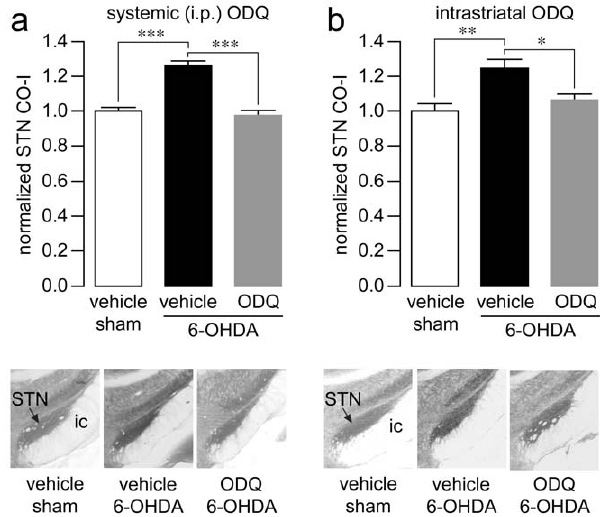
Figure 3. Role of the indirect striatopallidal pathway in mediating the ODQ-dependent reversal of STN hyperactivity. ( a ) Bar graph showing levels of CO-I staining in the STN of sham- operated and 6-OHDA lesioned rats following systemic administration of vehicle or ODQ (20 mg/kg, i.p.). ODQ significantly reduced the increase in CO-I levels observed in the STN of 6-OHDA-lesioned rats (n=10–11 rats/group; *** P , 0.0005 as indicated, Tukey post-hoc test after significant one-way ANOVA). Inset: Examples of coronal sections of STN derived from CO-I staining showing the reversal effect of ODQ. ( b ) Summary of the effect of single intrastriatal infusion (0.1 m l/min for 10 min) of vehicle (0.5% DMSO in aCSF) or ODQ (50 m M) on STN CO-I staining. Intrastriatal ODQ also normalized the increased STN CO-I observed in 6-OHDA-lesioned rats (n=5–7 rats/group; * P , 0.05 , ** P , 0.005 as indicated, Tukey post-hoc test after significant one-way ANOVA). Inset: Sections of CO-I staining showing the reversal effect of intrastriatal ODQ on STN